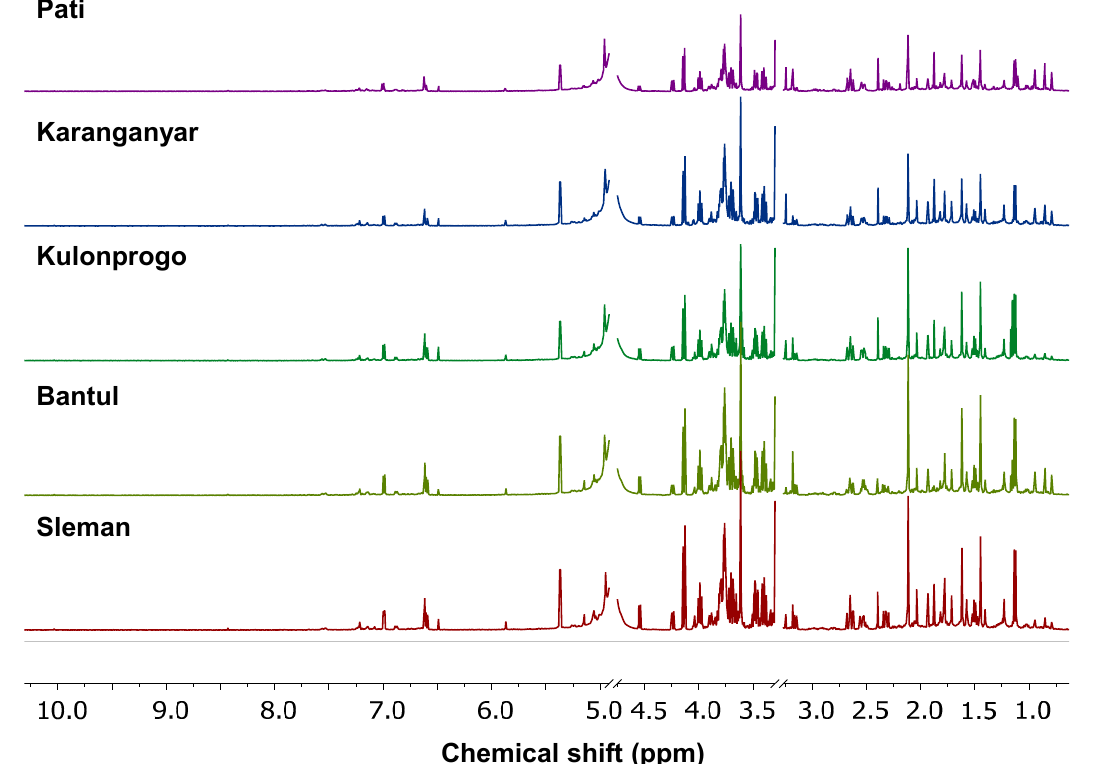
Figure 3. 1 H-NMR spectra of C. xanthorrhiza from several regions.